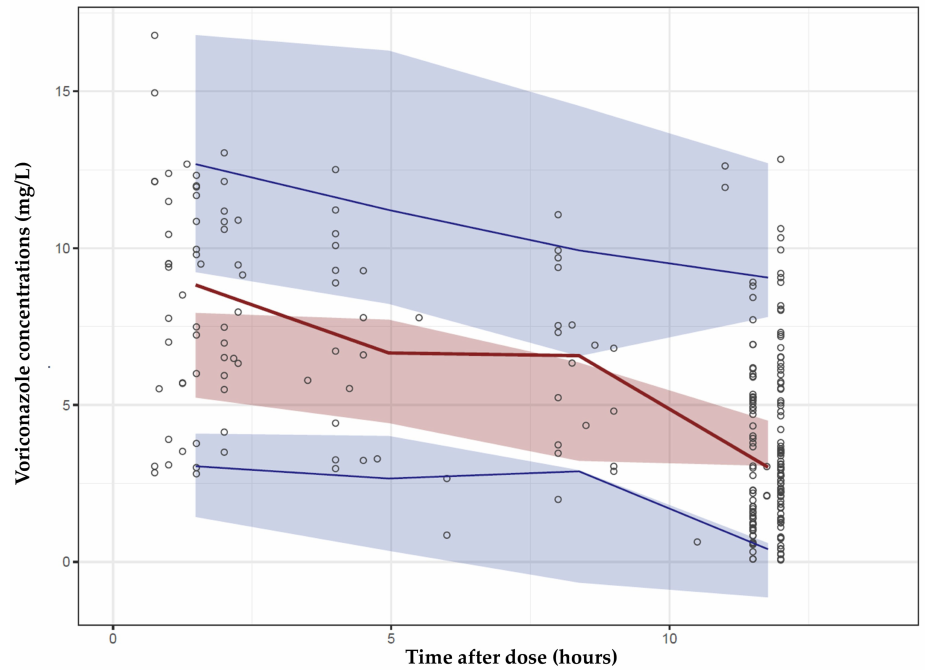
Figure 2. Prediction-corrected visual predictive check (pcVPC) plot of the final model. Open circles show observed plasma voriconazole concentrations. The red line is 50th percentile, and blue lines